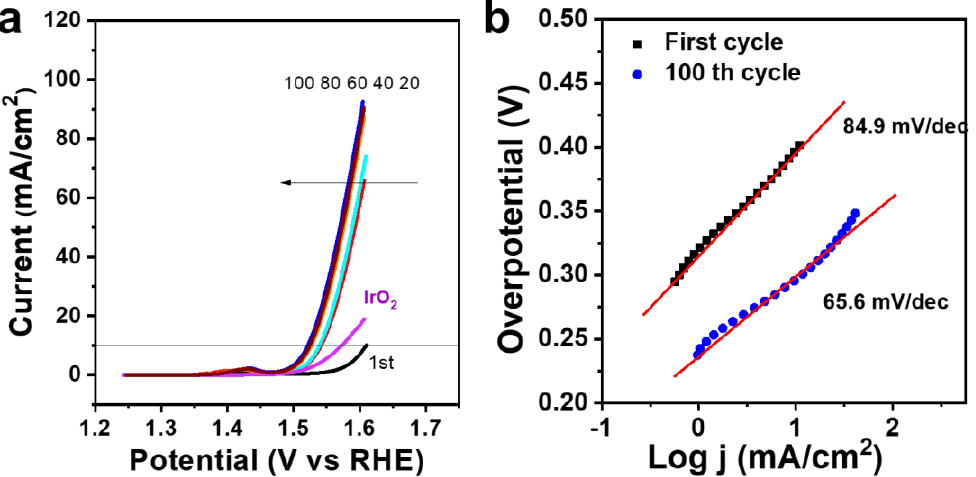
Figure 6. ( a ) Linear sweep voltammetry (LSV) curves and ( b ) Tafel plots of the FeS 2 /C catalyst at different cycles and the comparison with the IrO 2 catalyst. Scan rate - 1 mV/s. RHE, reversible hydrogen electrode.